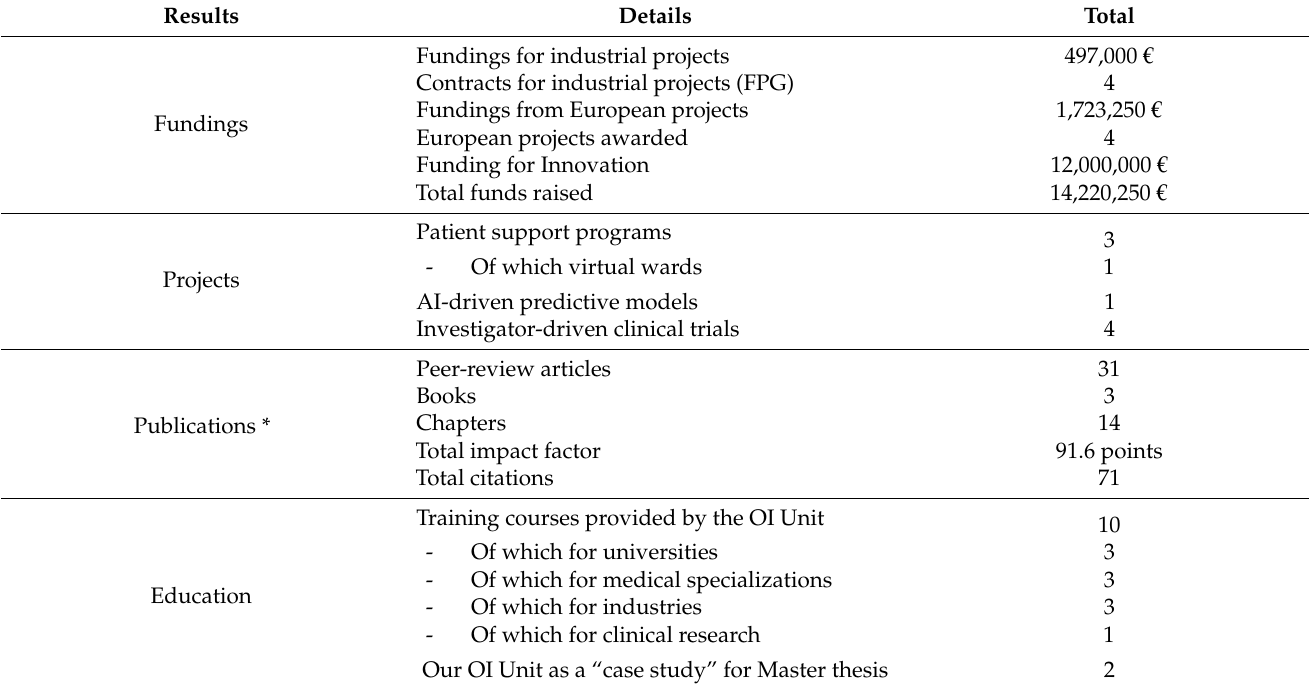
Table 2. Results from the OI interdisciplinary activities with G-STeP/Gemelli Generator and other units at FPG (July 2020–July